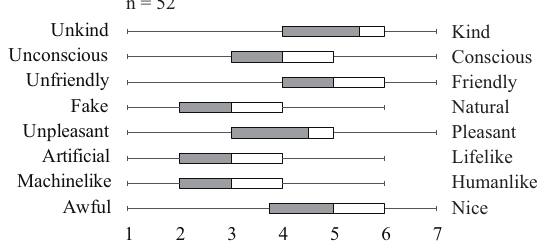
Figure 6. Results using semantic differential to evaluate the impressions of Pepita’s